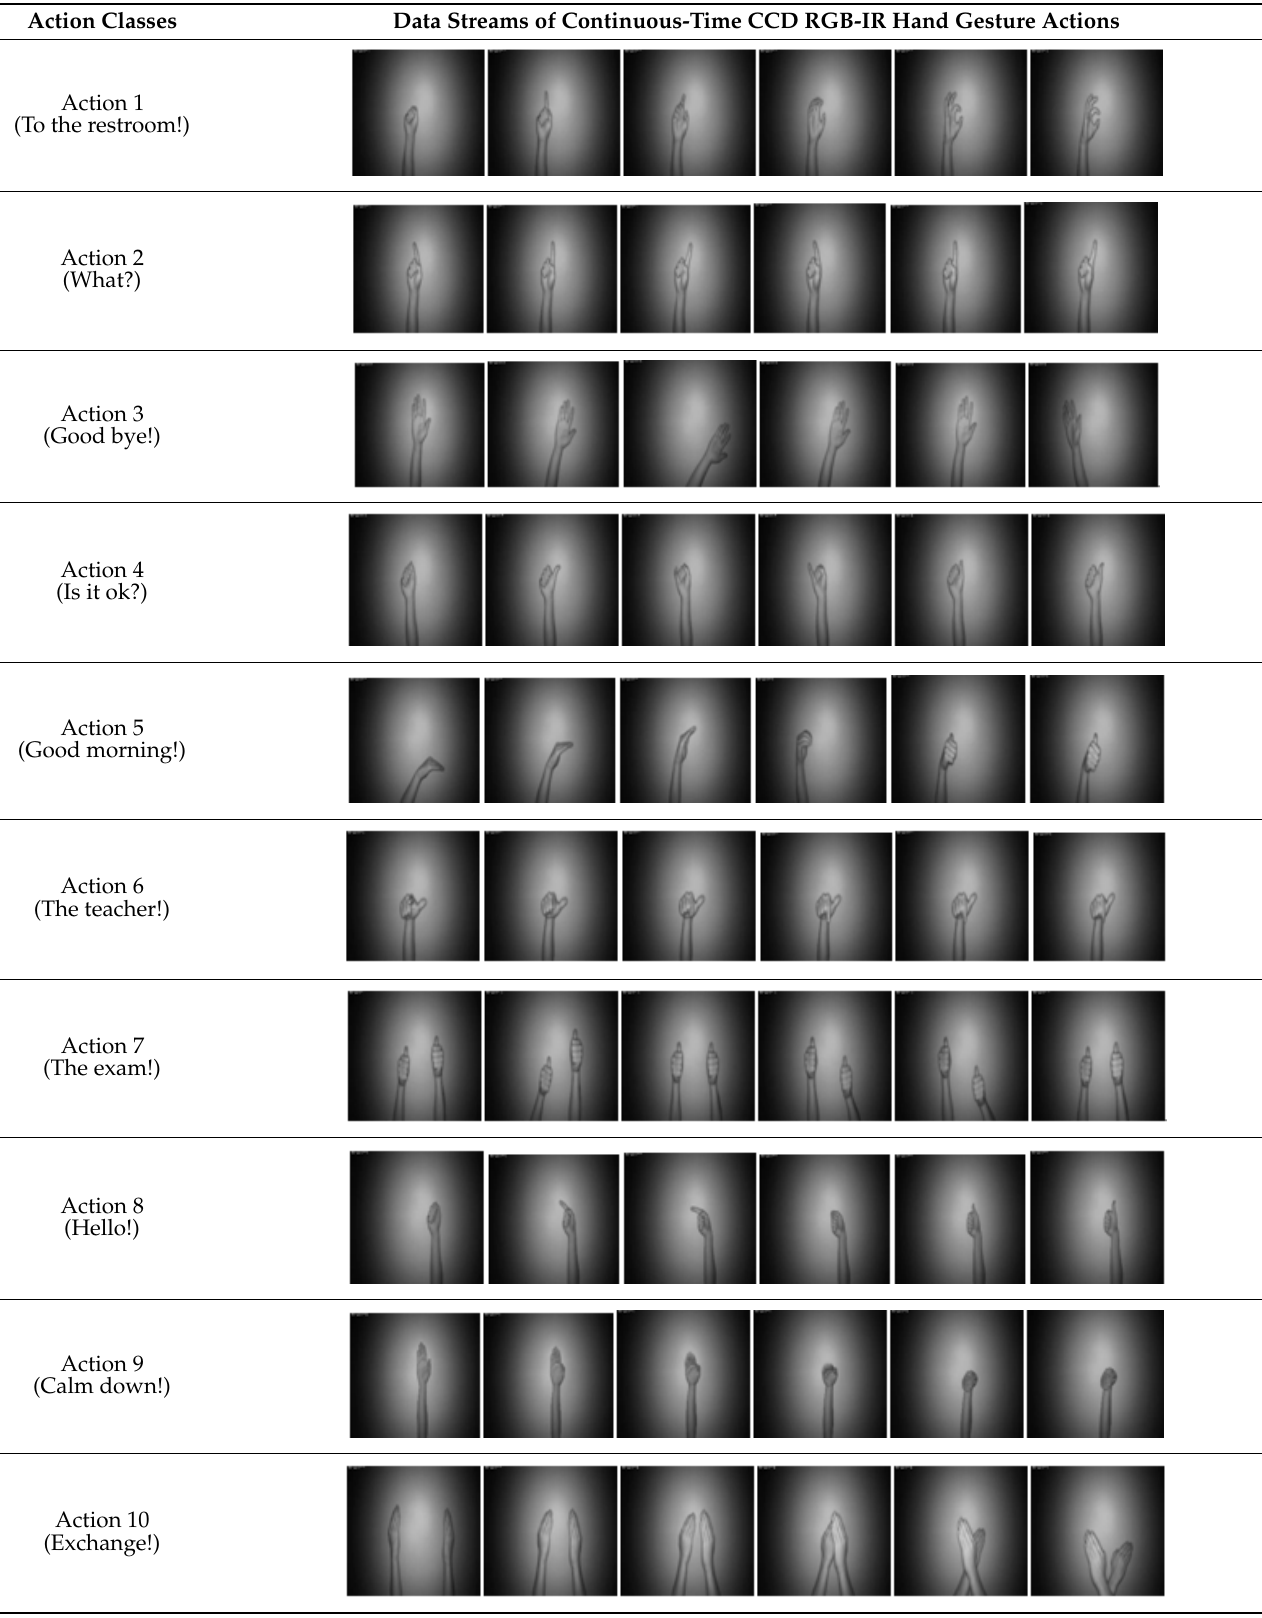
Table 1. A database of ten continuous-time hand gesture intention actions established for evaluation of the presented deep learning with wavelet-based image fusion (the modality of CCD RGB-IR) [27].